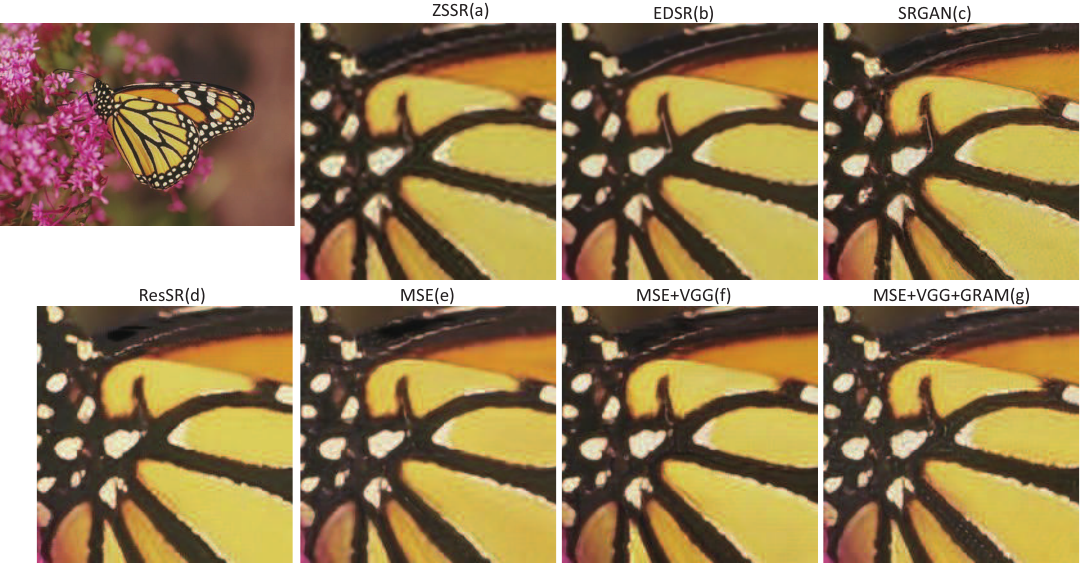
Figure 1. A comparison of some SR results. The figure shows the generation of ZSSR (an unsupervised DL-SR method), EDSR (a supervised method with best PSNR score), SRGAN (method good at the perceptual learning), ResSR (the generator of SRGAN), and our proposed method with three different loss functions. From the details, we can infer that more pleasant details are shown in the last pictures. The generations of different loss functions further provide change route of